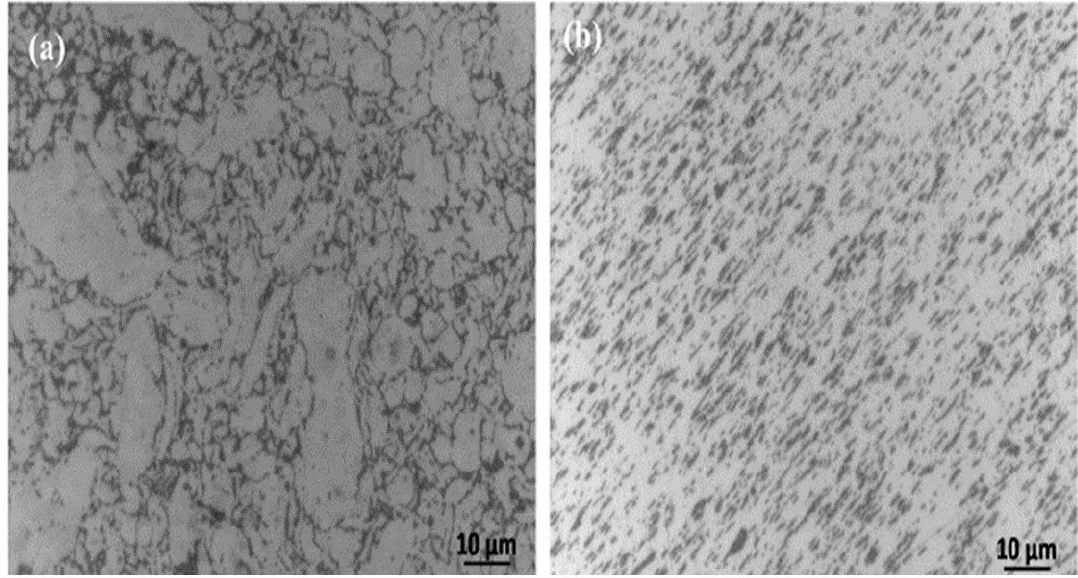
Figure 3. Light microscopy micrographs (a) as-SPSed and (b) as-extruded samples respectively.